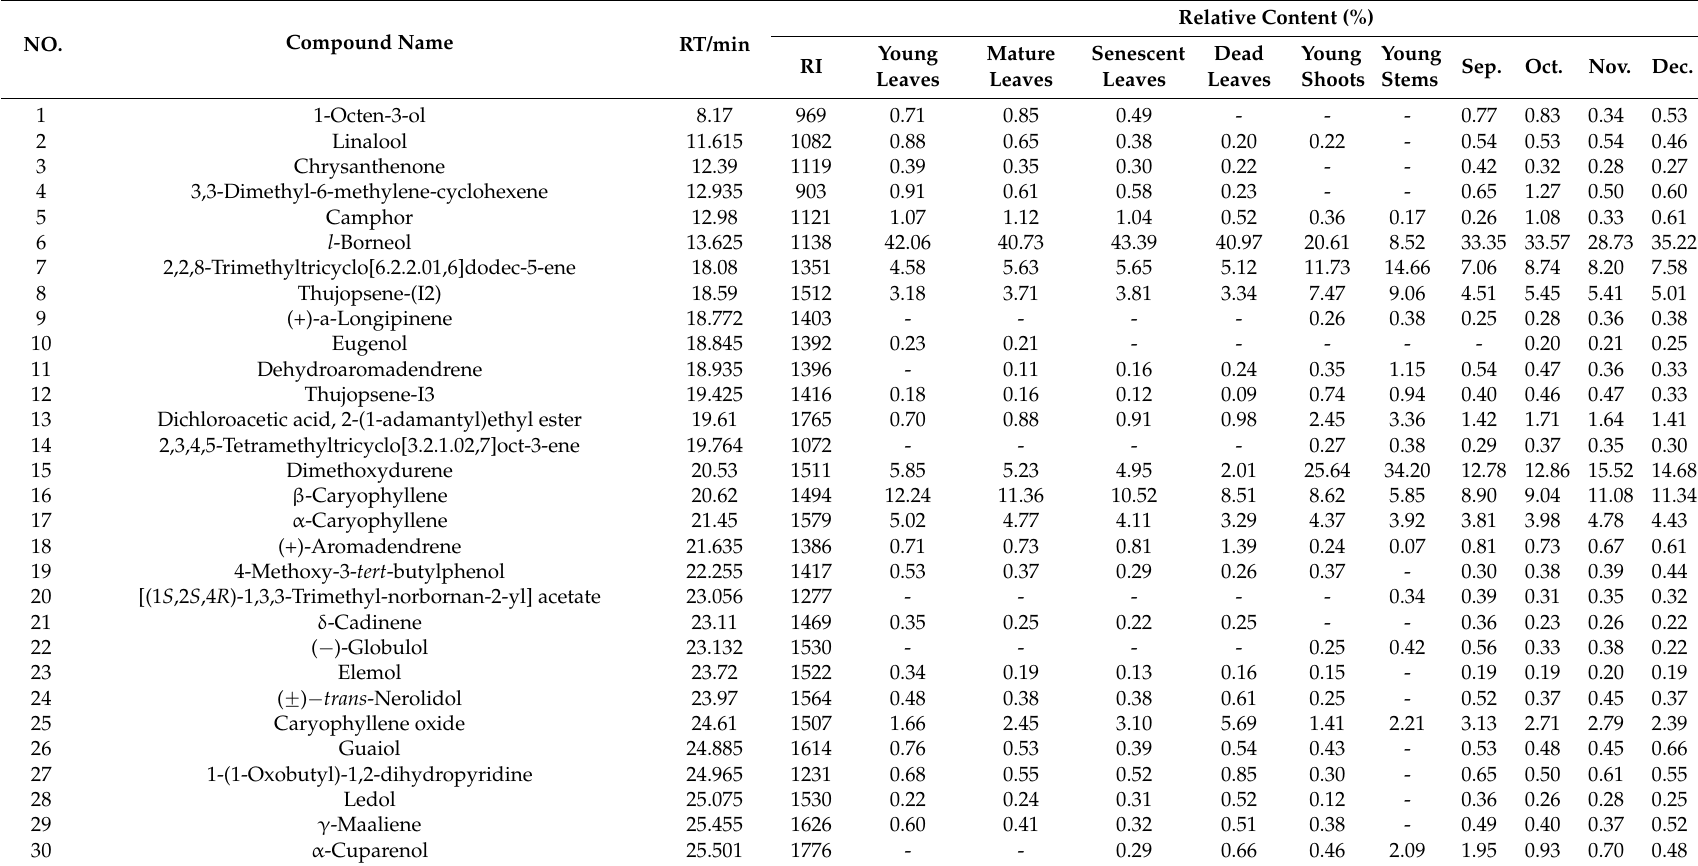
Table 2. Volatile compositions of essential oils from different plant organs and different months of B. balsamifera